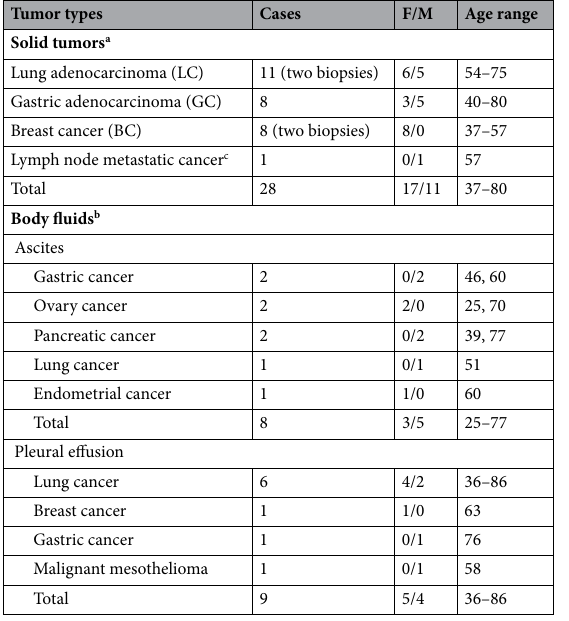
Table 1. Clinical samples. a All solid tumors were from surgical operation except four from biopsies (as labelled). b Body fluids were freshly collected from the chest or abdomen cavity of patients with malignant cancer. These samples were called “liquid samples” in this article. c Lymph node metastatic cancer: sample from metastatic lymph node of a gastric cancer patient. F/M: female vs.